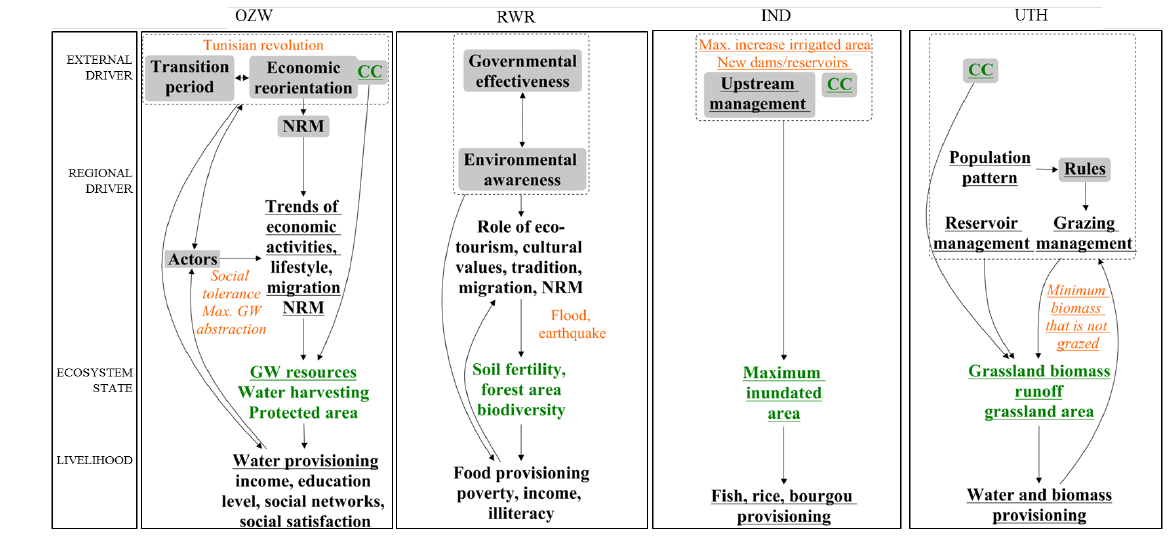
Fig. 3 . Scenario contents of each case study. Specified interactions between drivers are marked by arrows. Horizontal boxes (OZW, IND): only external scale scenario drivers used; vertical boxes (RWR, UTH): external and internal scale scenario drivers used. Green colors signify the natural system, black the human system, orange surprises, and orange italic colors thresholds. Grey boxes show where volition was addressed. Underlined concepts: quantitative parts of scenarios, else qualitative. CC = climate change, NRM = Natural Resources Management, OZW = Oum